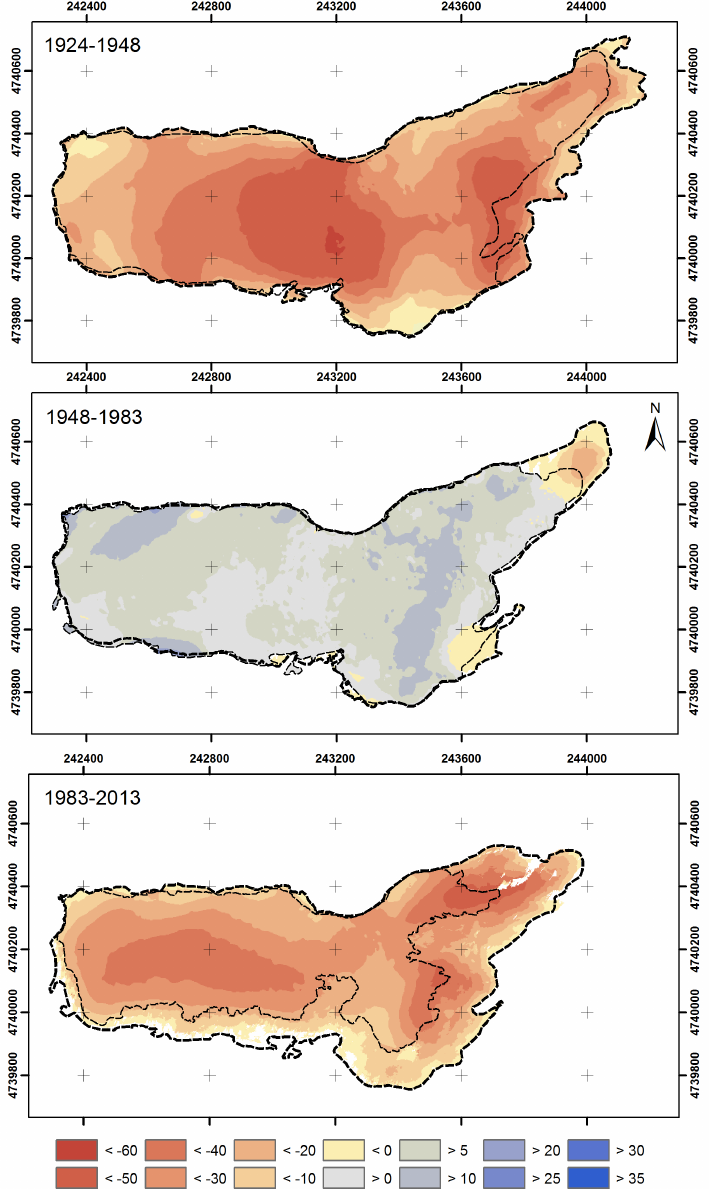
Figure 7. Elevations differences (m) on glacier (thin dashed line) and on deglaciated margins (thick dashed line) based on differences between consecutive DEMs. UTM 31 ◦ N